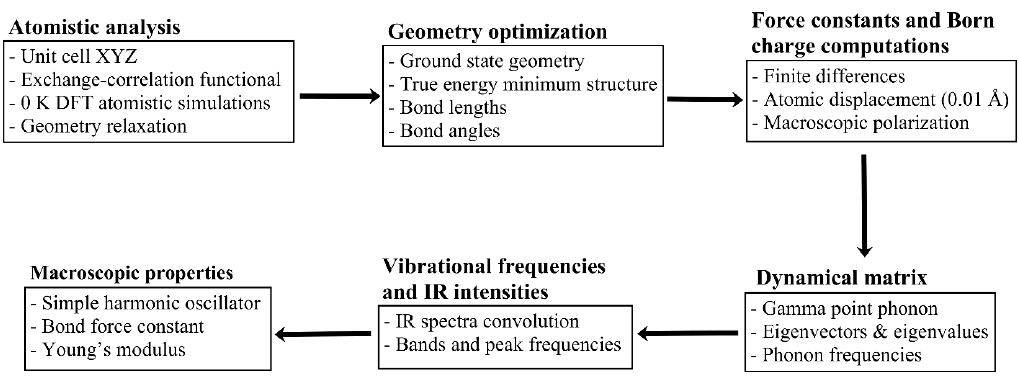
Figure 11. Computational platform formulated and executed in this work. Process to transform microscopic/vibrational analysis inputs into macroscopic properties’ output of the most important and representative sH gas hydrates.